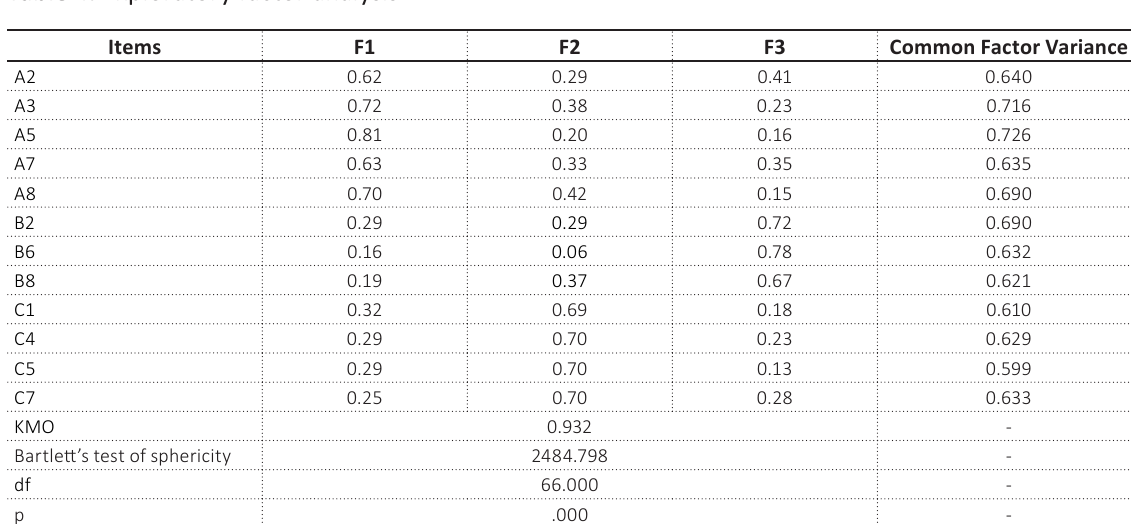
Table 4. Exploratory factor